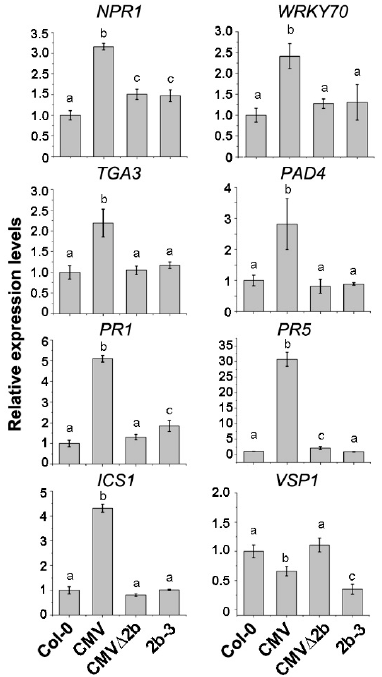
Figure 7. The relative expression of genes in SA and JA pathways in CMV-, CMV Δ 2b- and 2b-3 plants. Means identified by different letters are significantly different from each other. Error bars represent SEs from three biological replicates. One-way ANOVA followed by Tukey’s multiple comparisons test was used for statistical analysis ( P < 0.05).